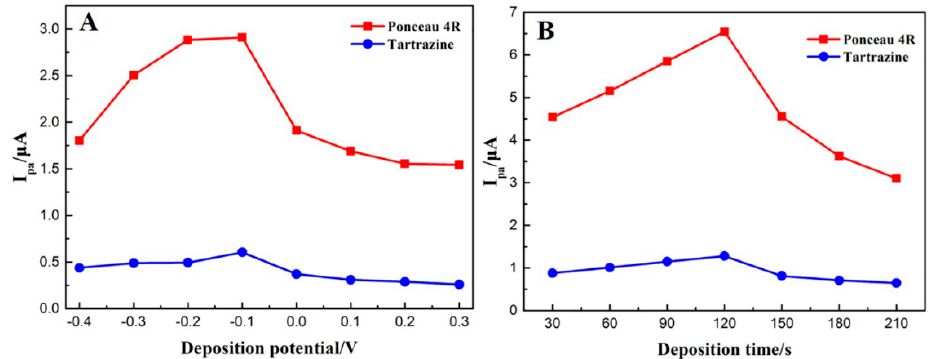
Figure 4. Effect of deposition potential ( A ) and deposition time ( B ) on the DPV anodic peak currents of ponceau 4R and tartrazine. (A) Deposition time was set at 150 s and (B) deposition potential was fixed at − 0.1 V.